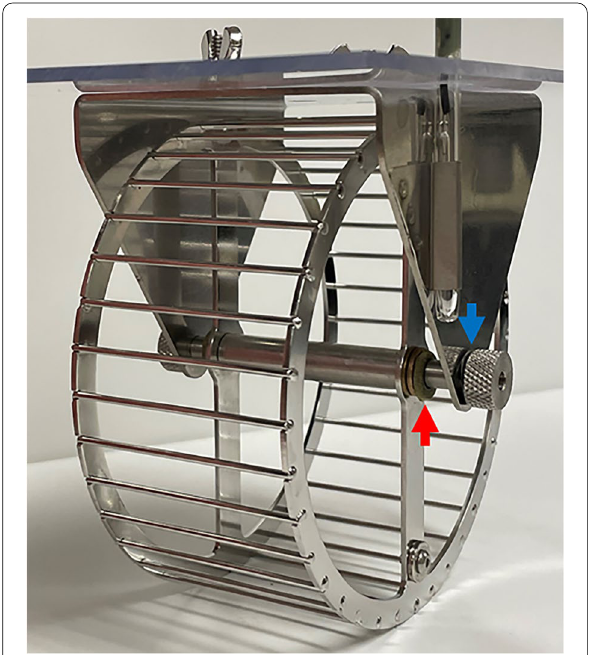
Fig. 1 Resistive cage wheel setup. Red arrow points to Kevlar washer placed on the axle on both sides of the wheel to apply rotational resistance. Blue arrow point to Belleville disc spring used to maintain resistance during wheel